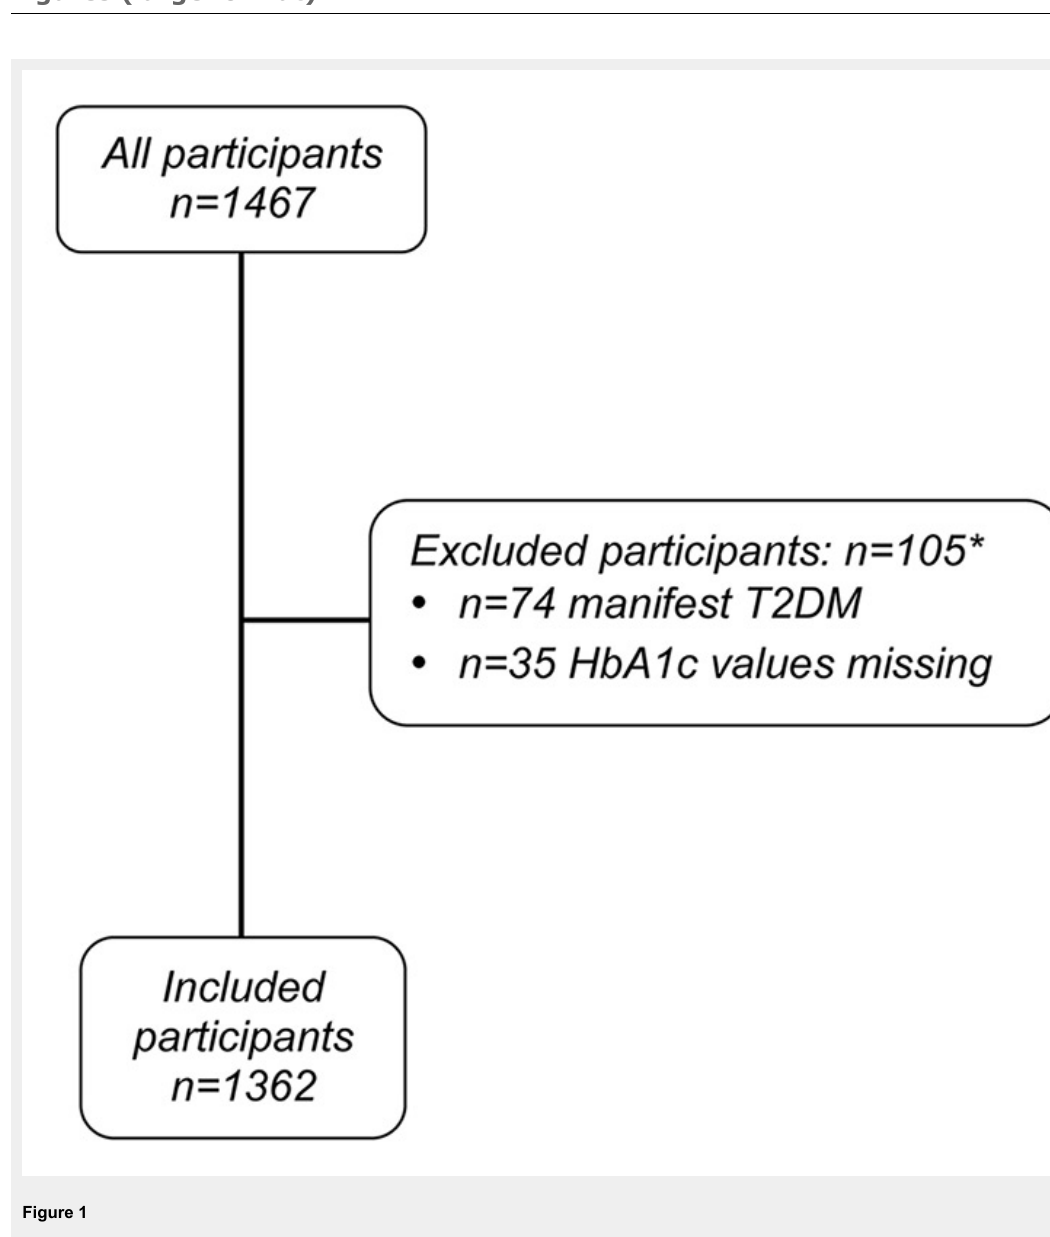
Figure 1 Study flow diagram. In addition to the exclusions for known diabetes mellitus, we had to exclude subjects in whom the relevant laboratory tests were not available. * Four participants fulfilled both exclusion